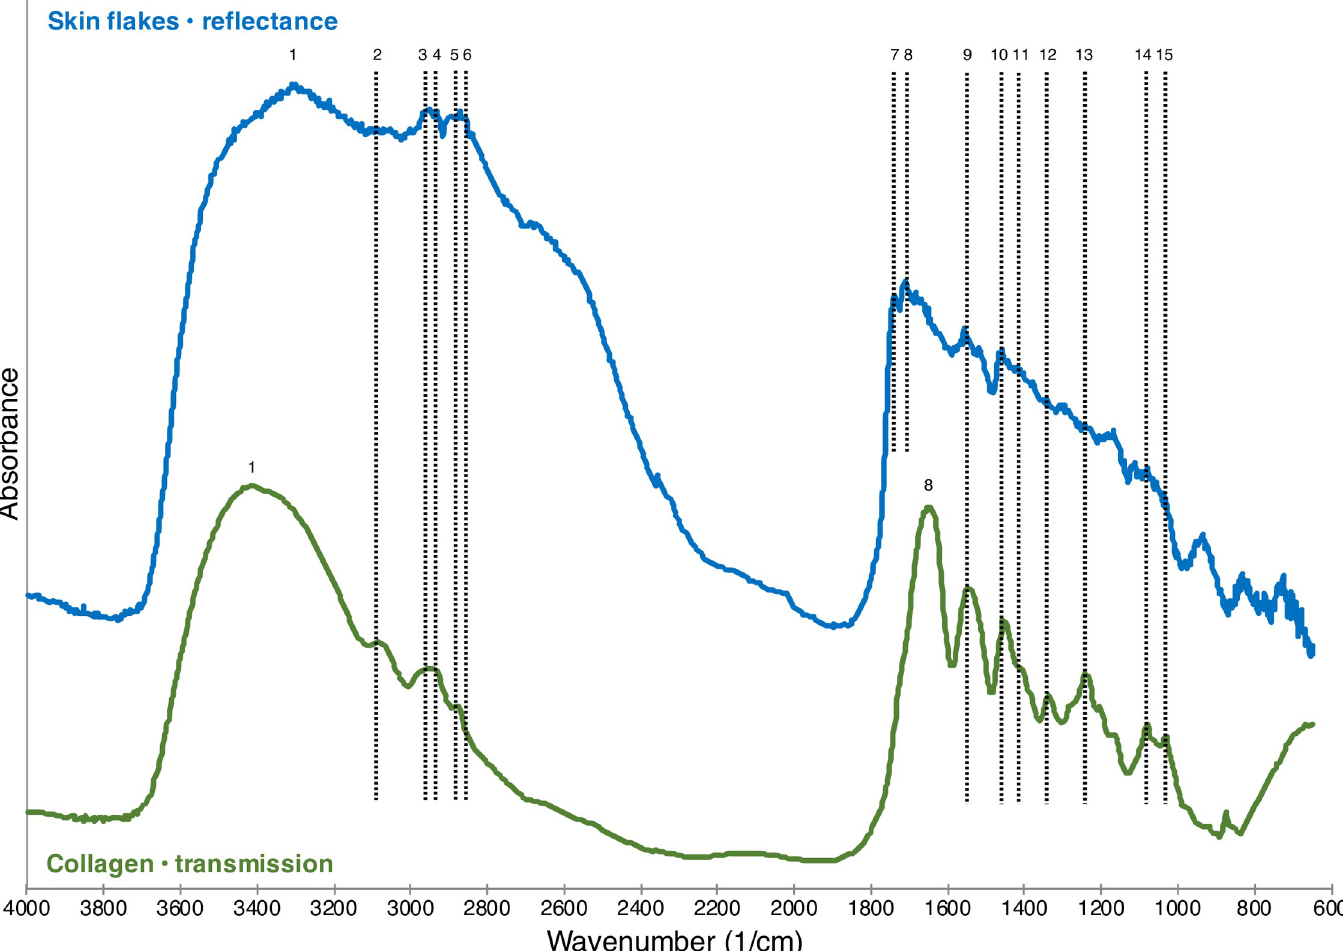
Fig 3. FTIR reflectance spectra for skin flakes. A μ FTIR spectrum of fresh human skin flakes compared to the transmission spectrum for collagen from the reference library of Kimmel Center for Archaeological Science, Weizmann Institute of Science. The spectra have been vertically offset for clarity. We propose the following peak identifications based on our earlier publications (see Monnier et al. [12] for further details): 1. O-H stretching, amide A; 2. amide B; 3. CH 3 asymmetric stretching; 4. CH 2 asymmetric stretching; 5. CH 3 symmetric stretching; 6. CH 2 symmetric stretching; 7. C = O stretching; 8. C = C stretching, amide I; 9. amide II; 10–12. CH x bending; 13. amide III; and 14 and 15. C-N, C-O, C-C